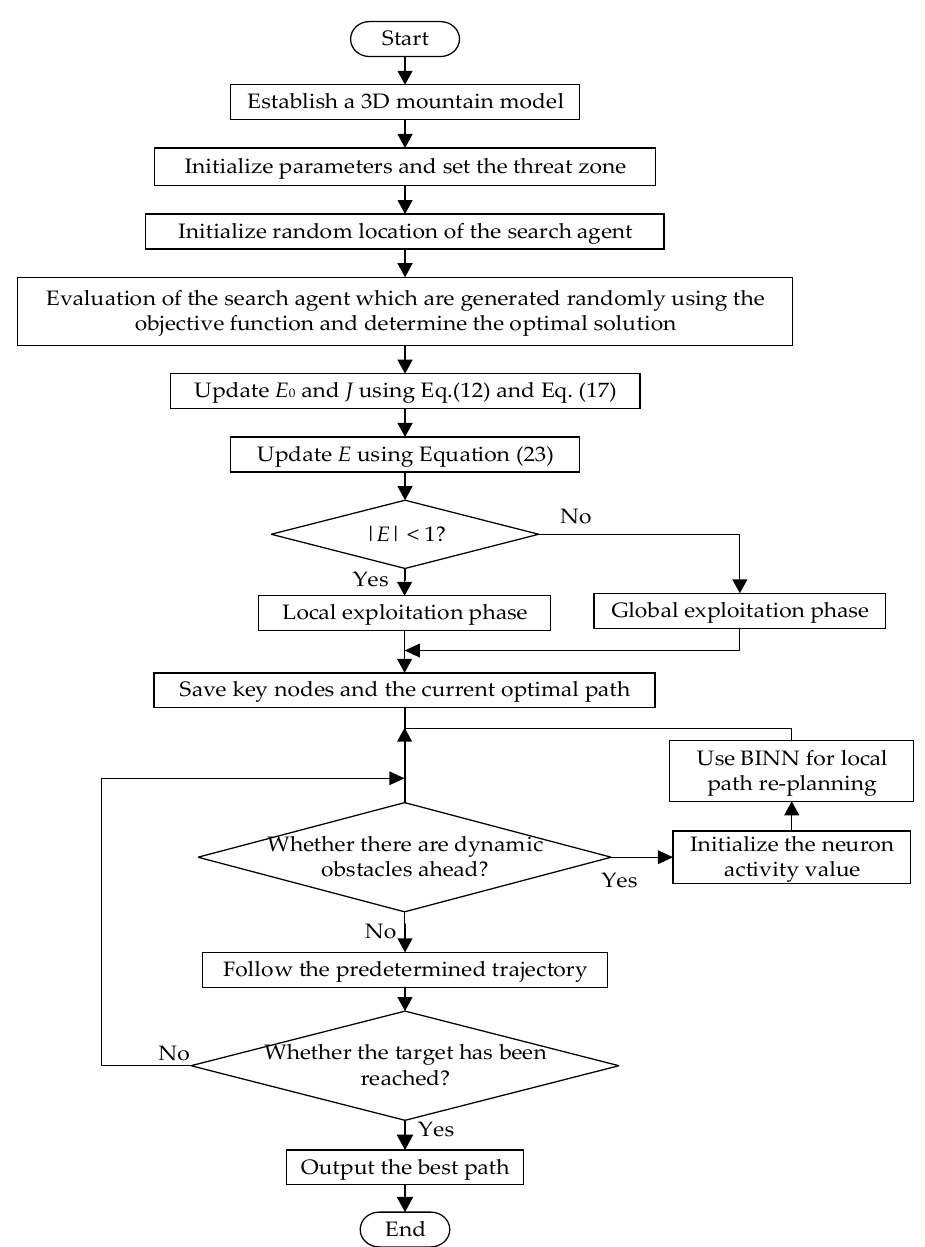
Figure 4. Flowchart of multi-UAV path planning based on BINN-HHO.